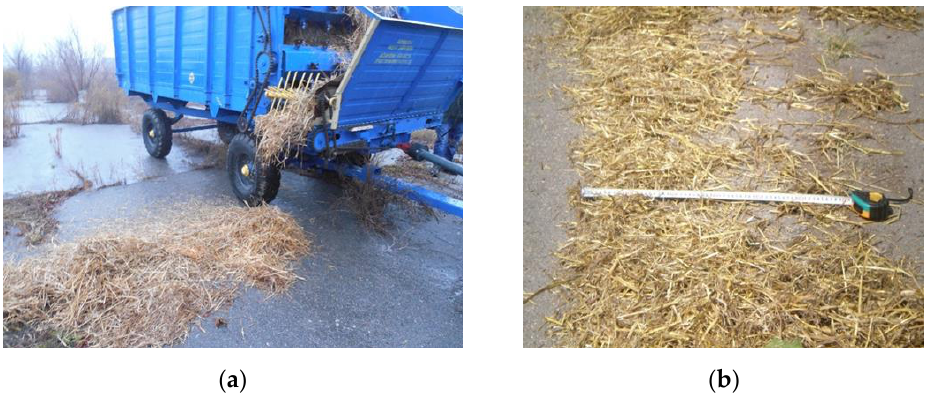
Figure 2. Determination of track length, passed by the mobile straw bedding spreader ( a ) and the spreading width ( b ).